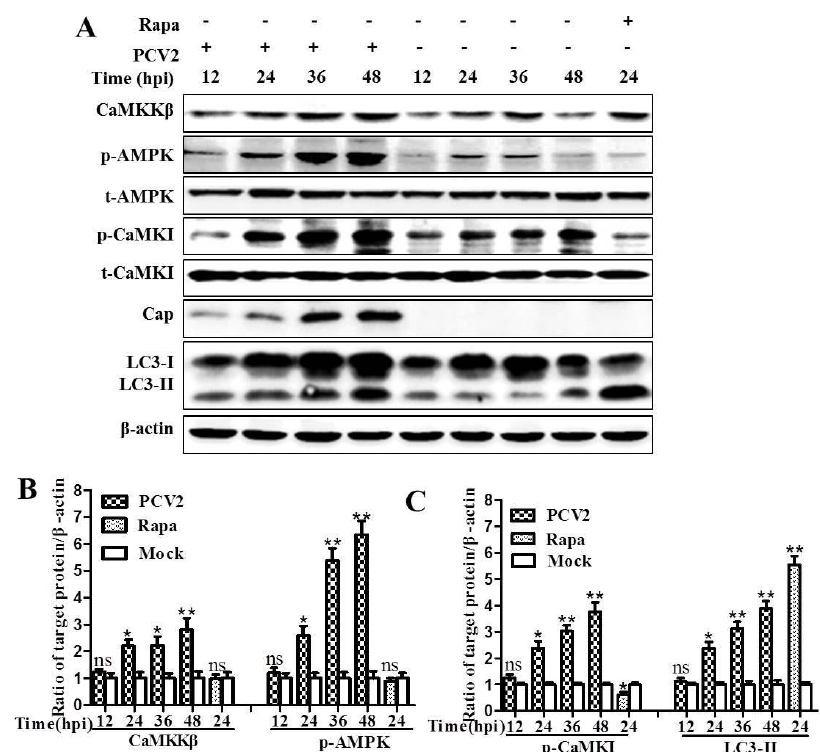
Figure 1. Porcine circovirus 2 (PCV2) infection activated calcium/calmodulin-dependent protein kinase kinase-beta (CaMKKβ) and its substrates calcium/calmodulin-dependent protein kinase I (CaMKI) and 5' adenosine monophosphate-activated protein kinase (AMPK), as well as increased lipidation of microtubule-associated microtubule-associated protein 1 light chain 3 (LC3-II). PK-15 cells were infected with PCV2 (multiplicity of infection (MOI) ≈ 1) or mock-infected for the indicated time points. Whole cell lysates were subjected to Western blotting for CaMKKβ, phosphorylated AMPK (p-AMPK), total AMPK (t-AMPK), phosphorylated CaMKI (p-CaMKI), total CaMKI (t-CaMKI), viral capsid protein (Cap), and LC3-II. ( A ) Representative images of Western blotting for target proteins of cells at 12, 24, 36 and 48 hours post-infection (hpi); ( B ) ratios of CaMKKβ and p-AMPK to β-actin; ( C ) ratios of p-CaMKI and LC3-II to β-actin. Ratios of targeted proteins to β-actin were normalized to mock infection set at 1.0. Data are reported as the mean ± SEM of three independent experiments (ns, p > 0.05; * p < 0.05; and ** p <